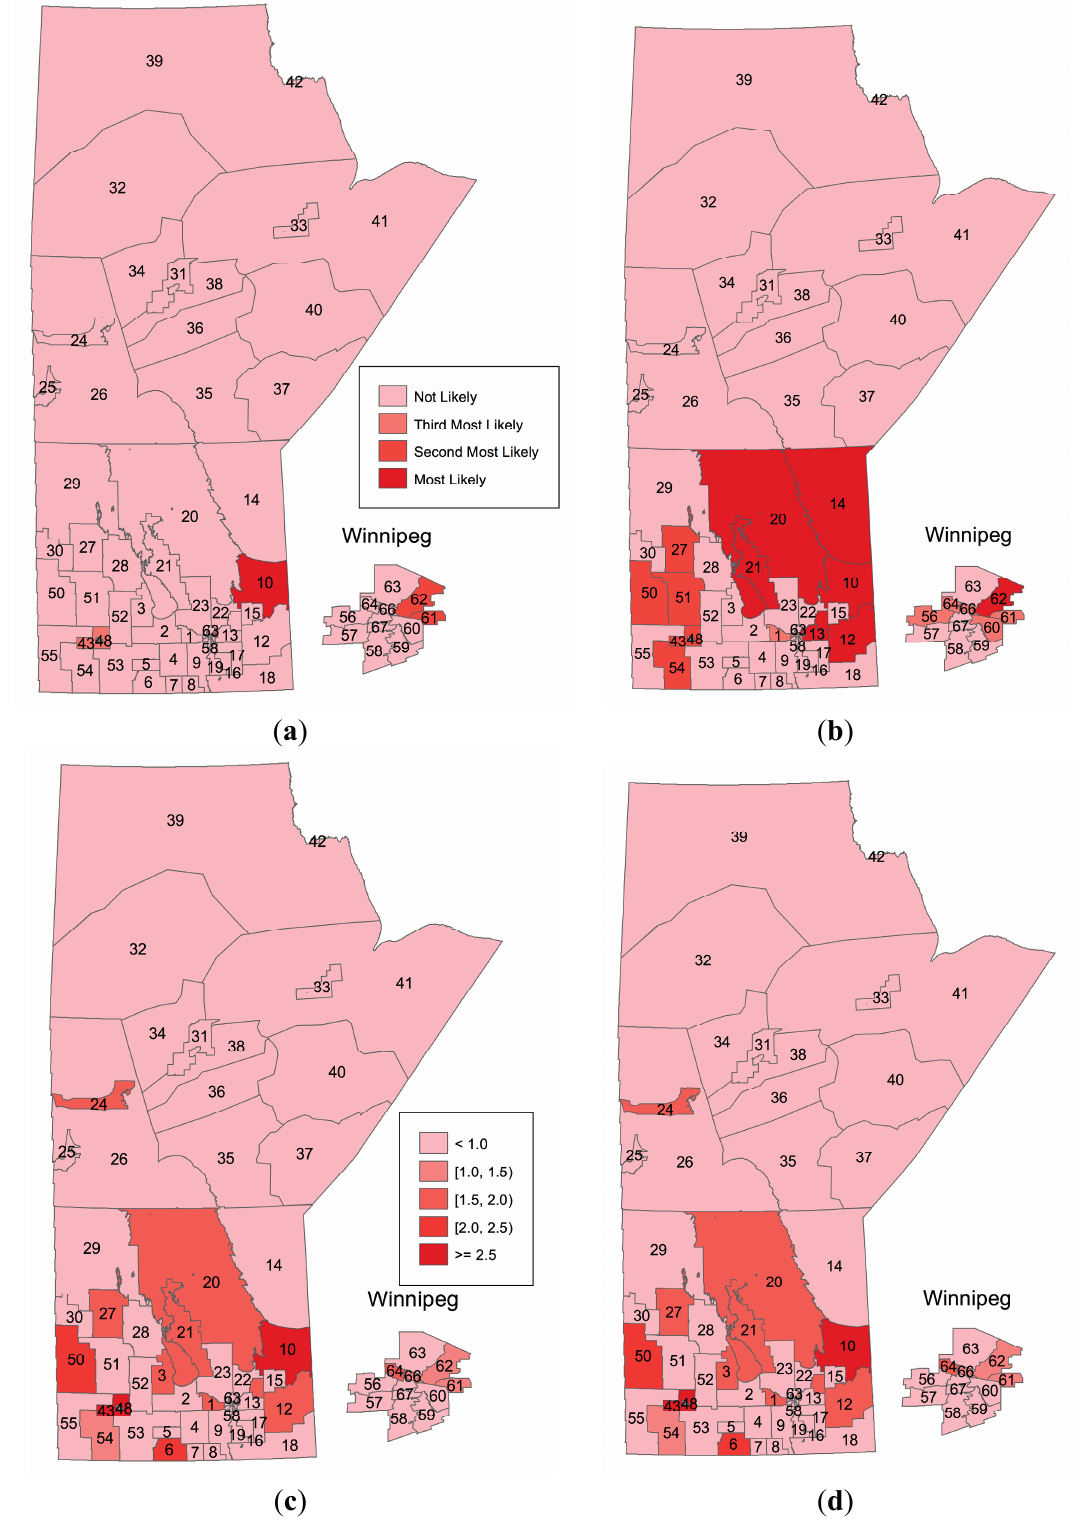
Figure 1. The order of most likely clusters of COPD for the CSS, FSS, and LISA (based on the p -value) methods, and the special effects of the regional COPD risks for the BYM and MLE methods; in the case of cluster A. Major urban centre (Winnipeg region) is incorporated as an inset. ( a ) CSS; ( b ) FSS; ( c ) BYM; ( d ) MLE; ( e )